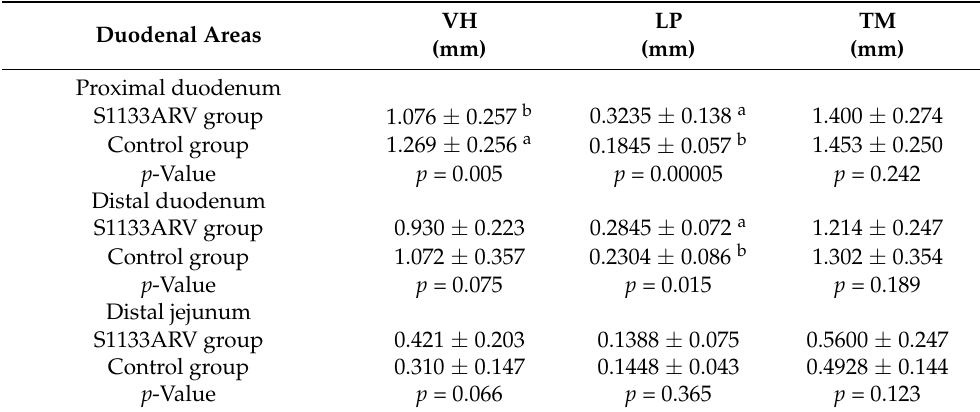
Table 5. Histological measurements of the enteric mucosa from broiler chickens vaccinated with the avian reovirus S1133 strain.